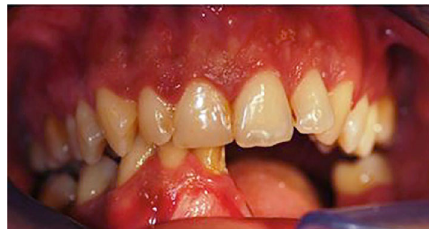
Figure 5: Clinical appearance after 2 years postresective surgery- frontal view.